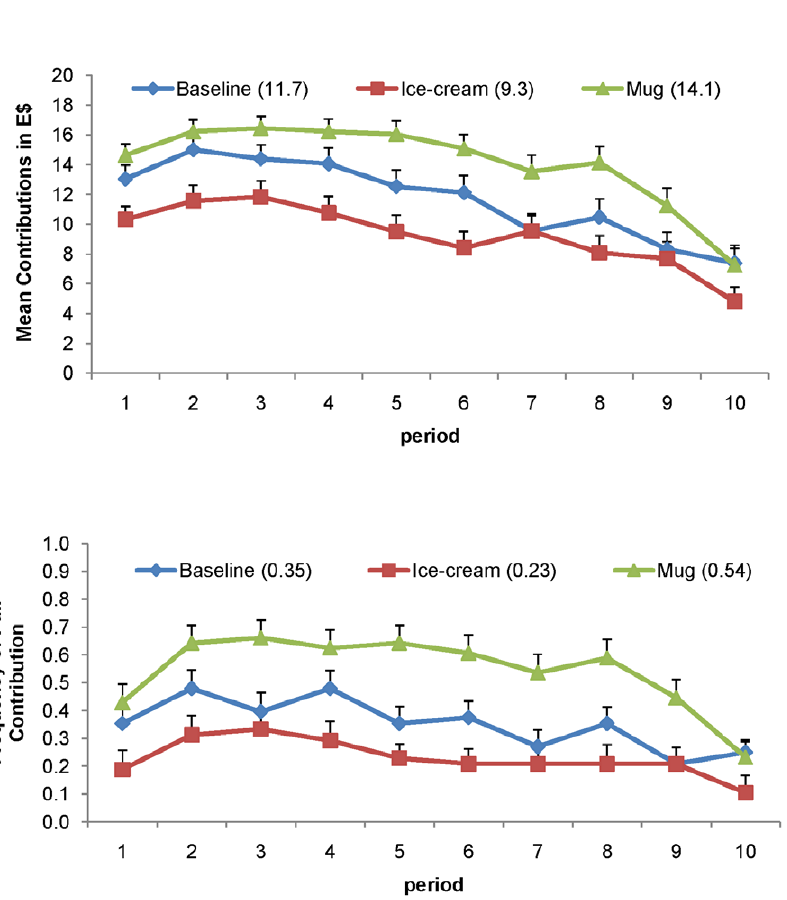
Figure 2. Contributions to the public goods over 10 periods across treatments. Cooperation is highest in Mug both by a) average contribution or b) frequency of the full contribution. a. The numbers in parentheses indicate mean contribution (over 10 periods) for that treatment. Contributions are significantly higher in Mug (N=14 groups) compared to both Ice-cream (N=12 groups, z=2.675, P=0.008) and Baseline (N=12 groups, z= 2 1.800, P=0.072). b. The numbers in parentheses indicate mean frequency (over 10 periods) of full contributions in that treatment. In the Mug treatment, most subjects contributed their full endowment (54%), significantly more than in both Baseline (35%, N=12 groups, z= 2 1.987, P=0.047) and Ice-cream (23%, z=2.734, P=0.006).